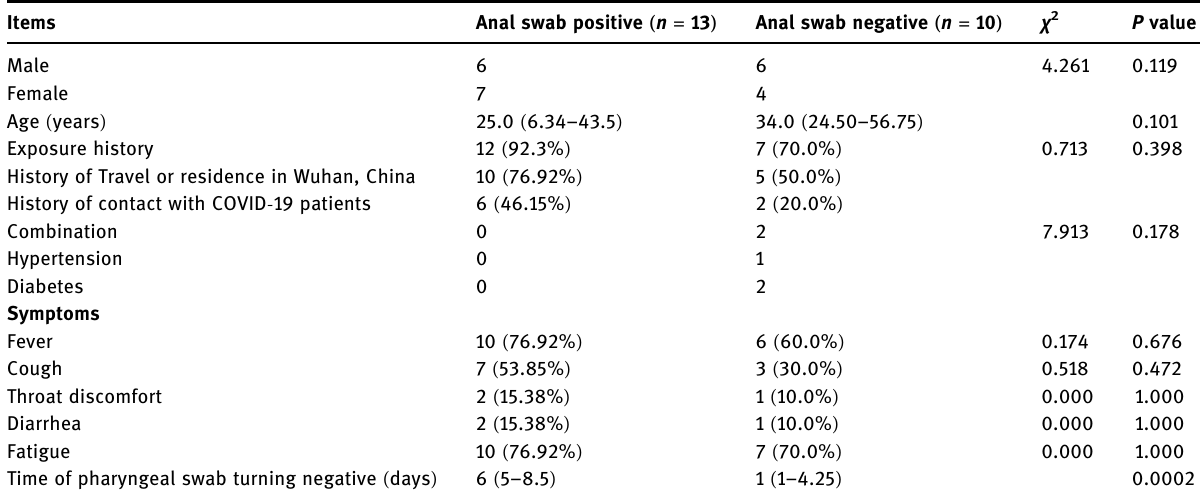
Table 1: Demographic, epidemiological, and clinical data of COVID - 19